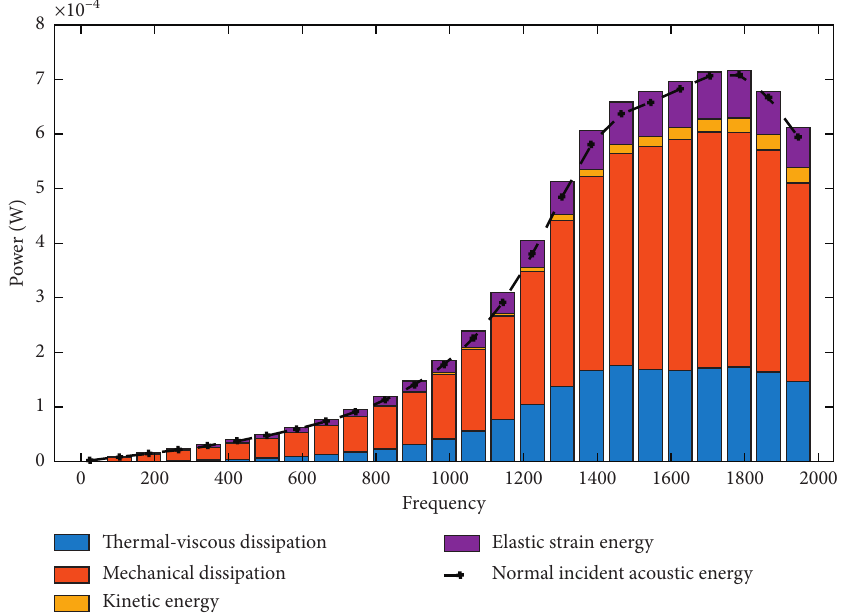
Figure 13: Energy spectrum of half of Al-rubber 2 composite structure.